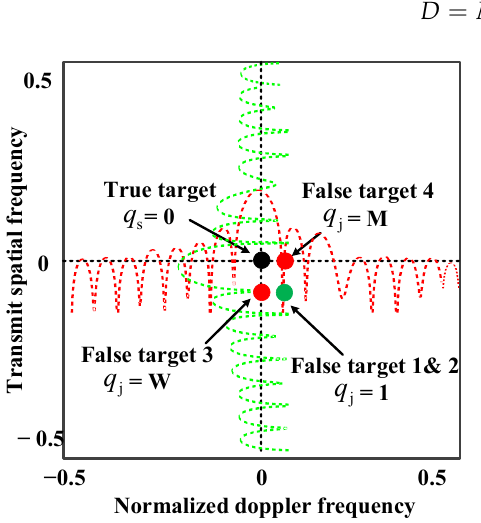
Figure 4. Distribution of the targets in joint transmit-Doppler domain.